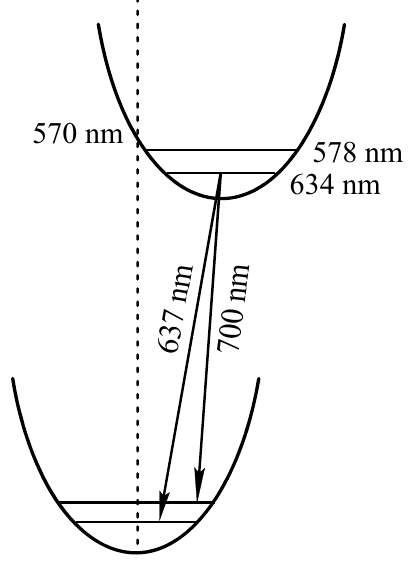
Scheme 1. A schematic detailing the ground and first excited singlet state potential curves of compound 2